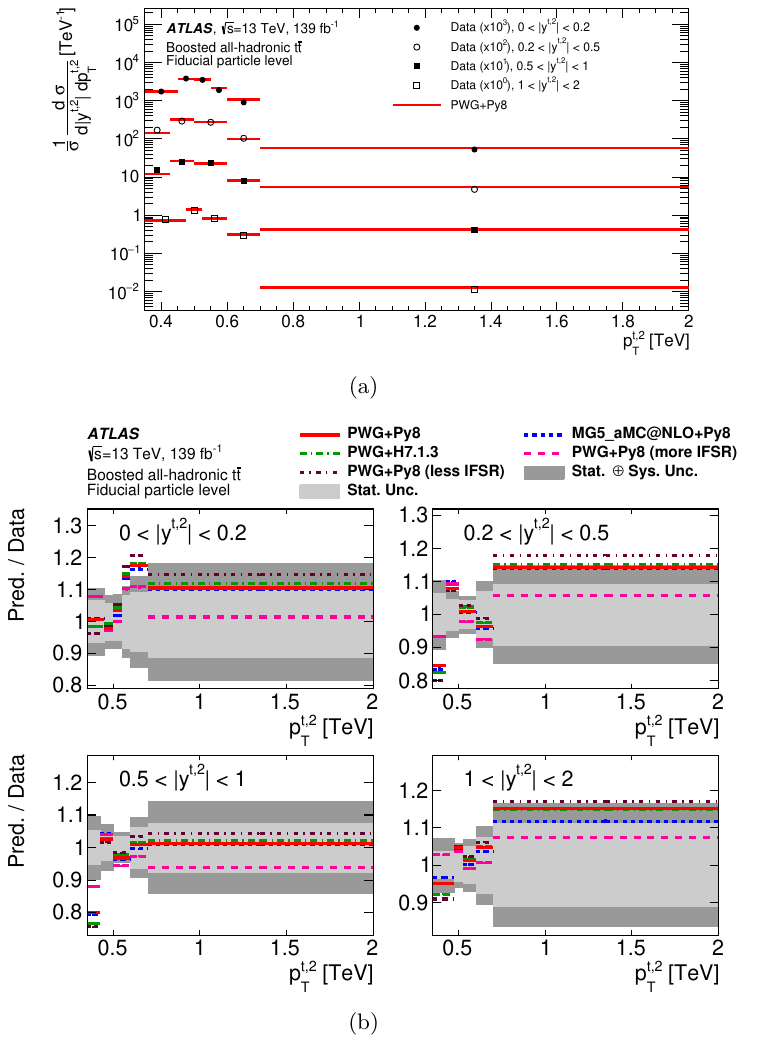
Figure 40 . (a) Normalized particle-level fiducial phase-space double-differential cross-sections as a function of the absolute value of the rapidity and transverse momentum of the second-leading top- quark jet, compared with the Powheg+Pythia 8 calculation. Data points are placed at the centre of each bin and the Powheg+Pythia 8 calculation is indicated by solid lines. The measurement and the prediction are normalized by the factors shown in parentheses to aid visibility. (b) The ratios of various MC calculations to the normalized particle-level fiducial phase-space differential cross-sections. The dark and light grey bands indicate the total uncertainty and the statistical uncertainty, respectively, of the data in each